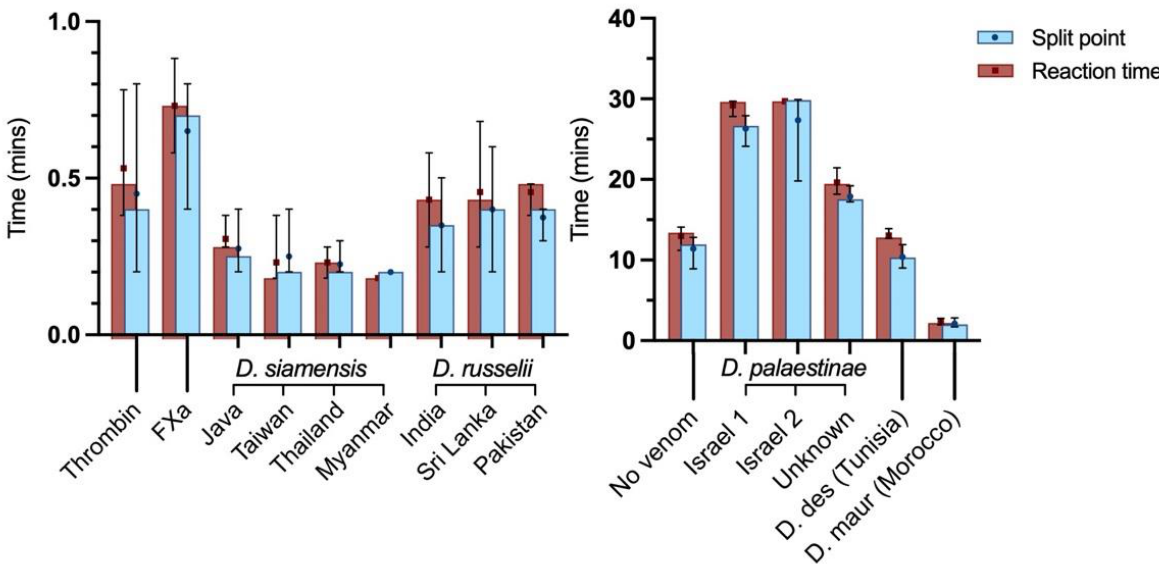
Figure 4. Thromboelastography of human plasma incubated with 20 µ g/mL venoms of: Left ) seven populations of the Asian clade of Daboia ; Right ) five populations of the Afro-Arabian clade Daboia . A total of 20 µ L/mL of thrombin and FXa were used as positive controls. Split point (SP), the time at which clot formation begins, signifies the initiation period of the enzymatic activity. Reaction time (R) denotes the time at which the clot has reached an amplitude of 2 mm. R–SP = conversion rate of prothrombin into thrombin, whereby a greater difference indicates a slower rate. The assay runs for 30 min at 37 ◦ C. Data presented are the mean (symbols), median (bars), and range (error bars) of four independent replicates. D. des = D. deserti , D. maur = D. mauritanica.